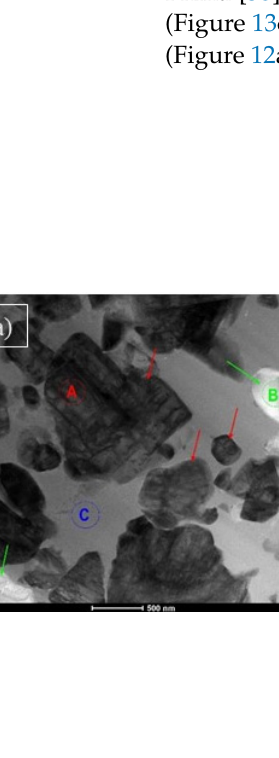
Figure 12. STEM micrograph in BF of sample C3 ( a ); the results of the chemical analysis performed for the area marked as A ( b ) and B ( c ) and C ( d ). Figure 13. SAED diffraction analysis of sample C3; for the area marked on Figure 12a with letter A: WC with direction [210] ( a ); with the letter B: Cr 3 C 2 with direction [010] ( b ); with letter C: amorphous matrix ( c ).